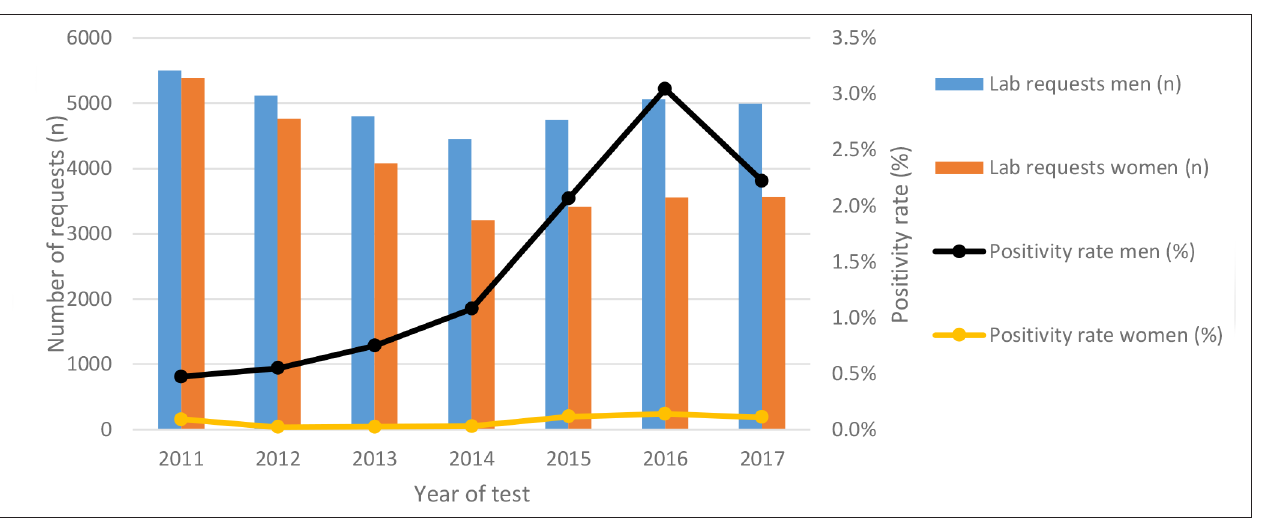
Figure 2 Annual number of lab requests and positivity rates in men and women. Positivity rate: number of syphilis diagnoses per number of